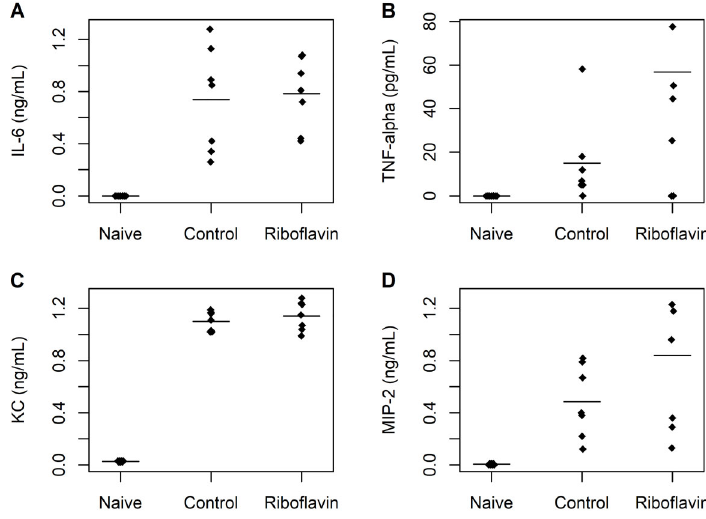
Figure 4. Serum concentrations of biomarkers of in fl ammation in naïve, control, and study groups (n=7 animals per group). A , Interleukin (IL)-6; B , tumor necrosis factor (TNF)-alpha; C , keratinocyte-derived chemokine (KC); D , macrophage in fl ammatory protein (MIP)-2. The horizontal bars represent means. There were no signi fi cant differences between control and study groups.